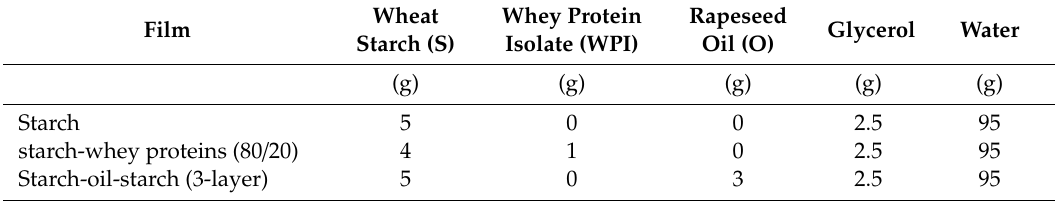
Table 3. Composition of film-forming solution (100g) used for both plum coating or film making. Film